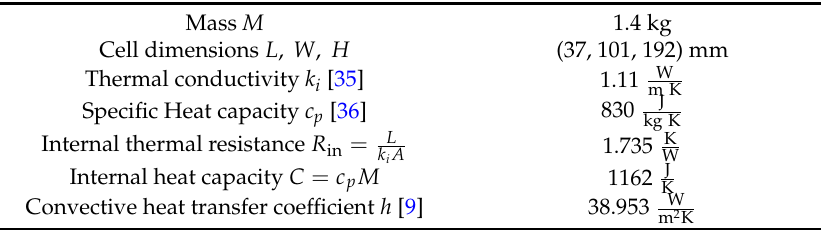
Table 1. Physical and thermal cell